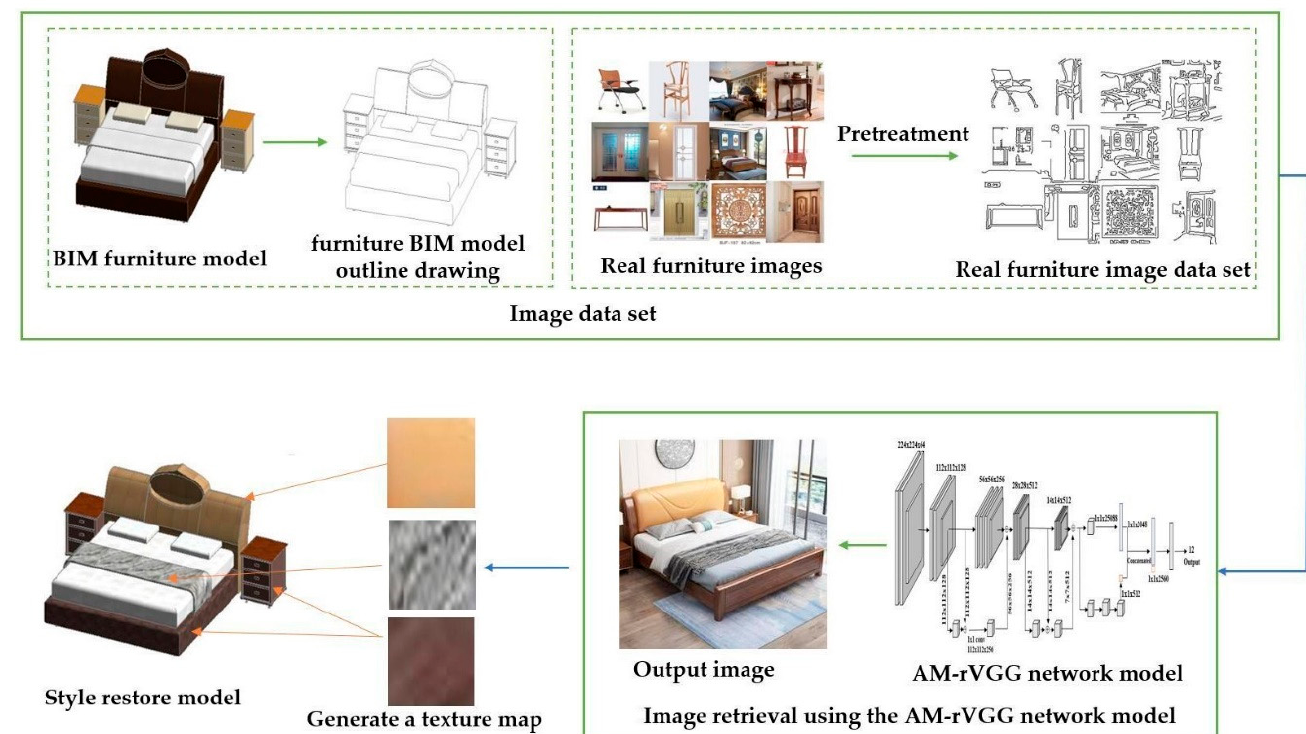
Figure 1. The overall framework of the BIM style restoration method.